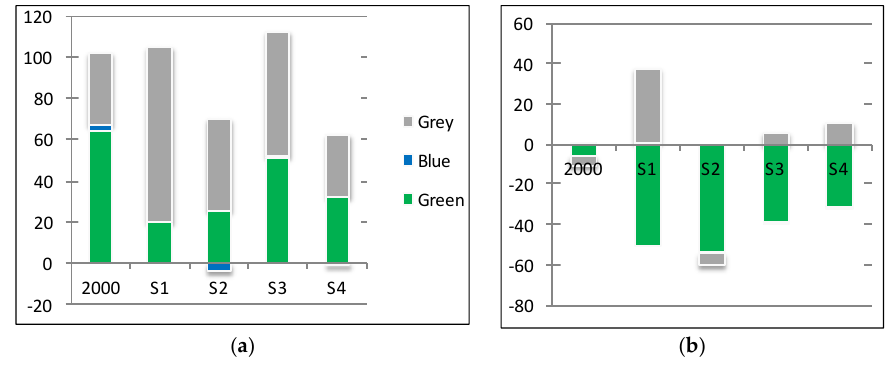
Figure 6. Net virtual water import by ( a ) Western Europe (WEU) and ( b ) Eastern Europe (EEU) (billion m 3 /year), specified by green, blue and grey components. Positive values represent net virtual water import; negative values represent net virtual water export.